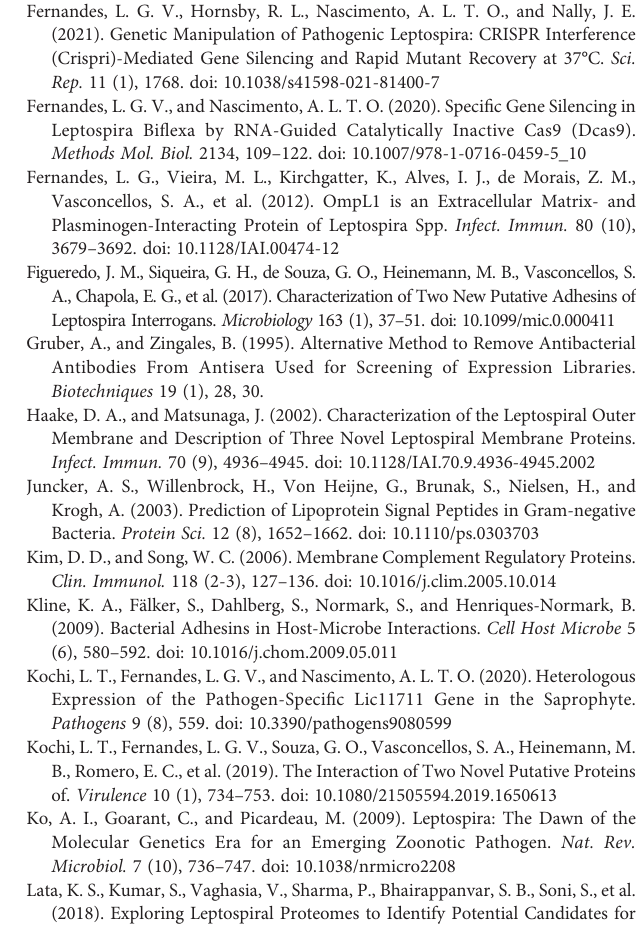
Supplementary Figure 1 | Recombinant protein reactivity with serum of con fi rmed leptospirosis. The recombinant protein was immobilized onto ELISA plates (A) (250 ng/well) or (B) (1,000 ng/well), and the reactivity was assessed by total IgG antibodies (1:100) in sera from leptospirosis patients at convalescent phase (MAT+) and detection with incubation of HRP-conjugated anti-human IgG (1:5,000). The cutoff values are represented by the horizontal line and de fi ned as the mean plus three standard deviations of the absorbances values from normal human serum (NHS). Supplementary Figure 2 | Western-blotting analysis. Recombinant protein rLIC13086 was separated by SDS-PAGE (12%), transferred to a nitrocellulose membrane, and detected by anti-rLIC13086 polyclonal antiserum (1:5,000). Supplementary Figure 3 | Cellular location of LIC13086 by immuno fl uorescence. L. interrogans serovar Copenhageni were fi xed with paraformaldehyde (2%), incubated with antiserum against LIC13086 (1:100) produced in mice, and detected with FITC-conjugated goat anti-mouse IgG (1:50). DAPI fl uorescent dye was used to stain fi xed cells in both samples. Microscope slides were prepared with ProLong Gold Antifade (Invitrogen). Images were captured in confocal immuno fl uorescence microscope LSM 510 META (Carl Zeiss). C+: Positive control with anti-LipL46, anti-LipL41, and anti-LipL21. C − : Negative control with anti-LipL31. Supplementary Figure 4 | Evaluation of divalent ions in rLIC13086. The protein rLIC13086 was treated with EDTA (3 mM), dialyzed in sodium-phosphate buffer, and supplemented with MgCl 2 (1 mM) or CaCl 2 (0.5 or 1 mM) and CD spectra were recorded for each sample. The spectra represent an average of 10